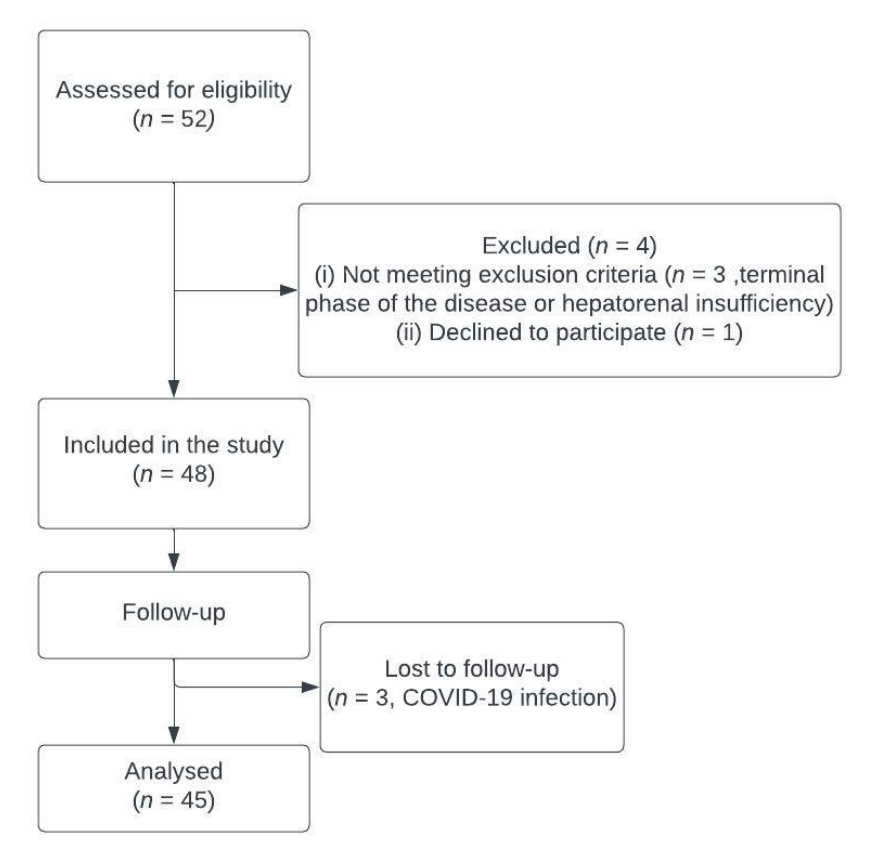
Figure 1. Participants